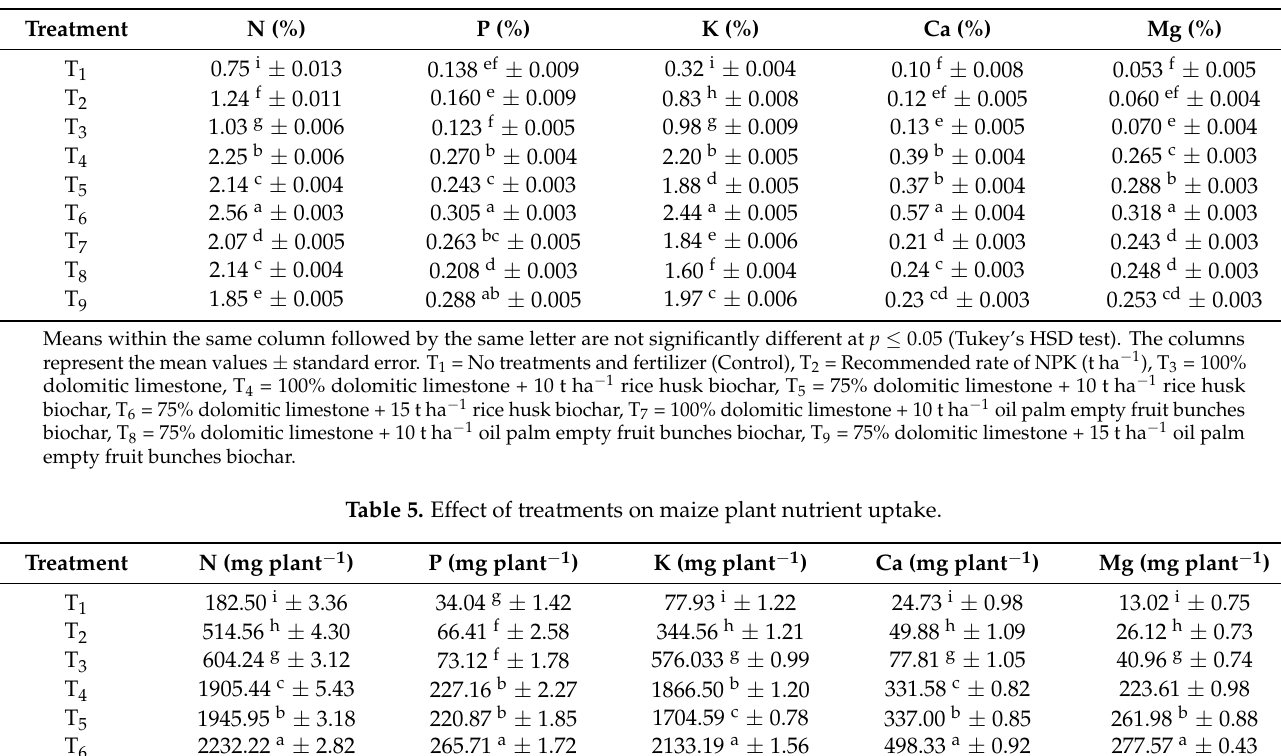
Table 4. Effect of treatments on maize plant nutrients’ concentration.